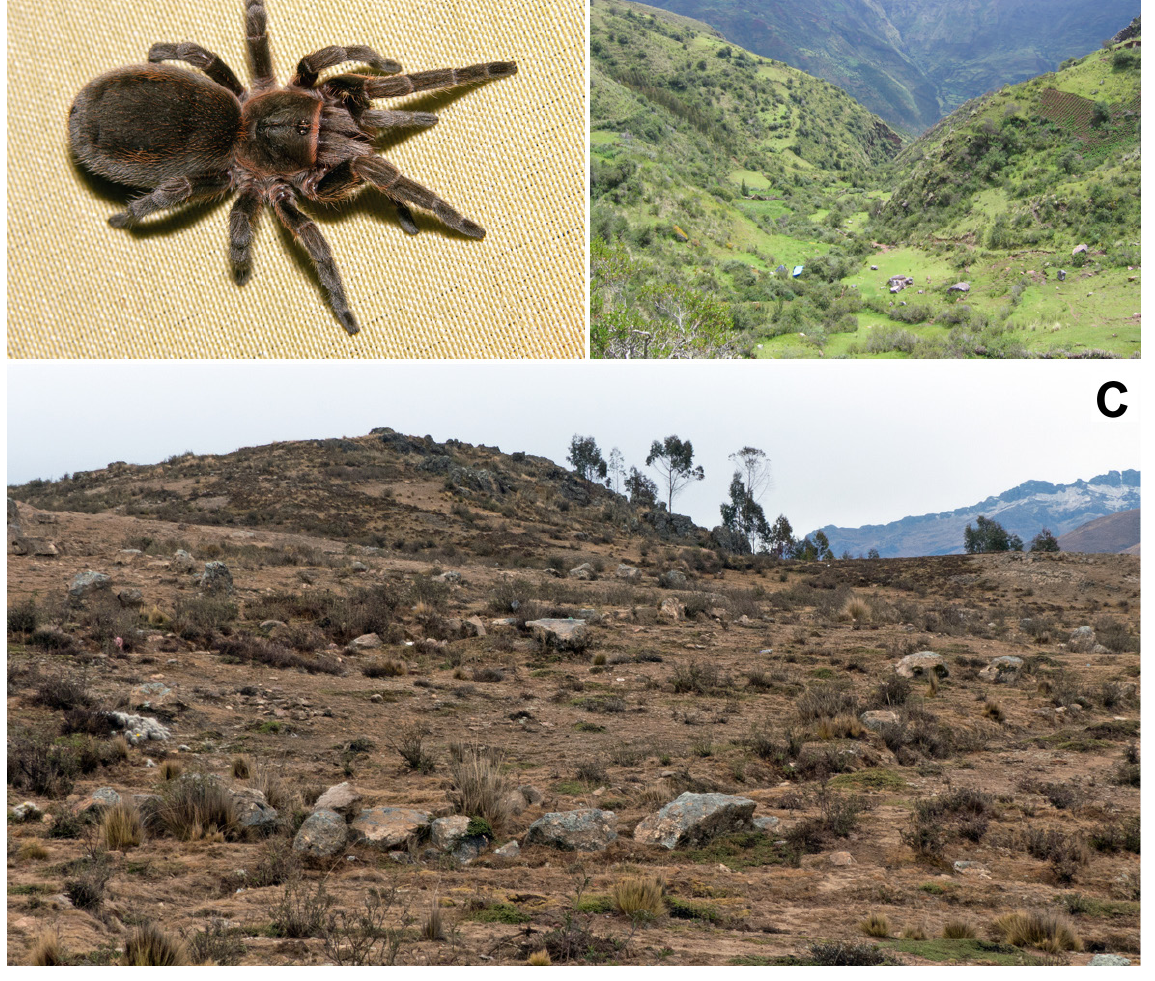
Fig. 11. Bistriopelma kiwicha sp. nov. A . Habitus, paratype, ♀ (MUBI 41). B . Habitat of male holotype in Peru, Llachoc. C . Habitat of female paratype in Peru, Cusco, Paucartambo, 3903 m.a.s.l. Photos: A, C = Rick C. West; B = José. A.